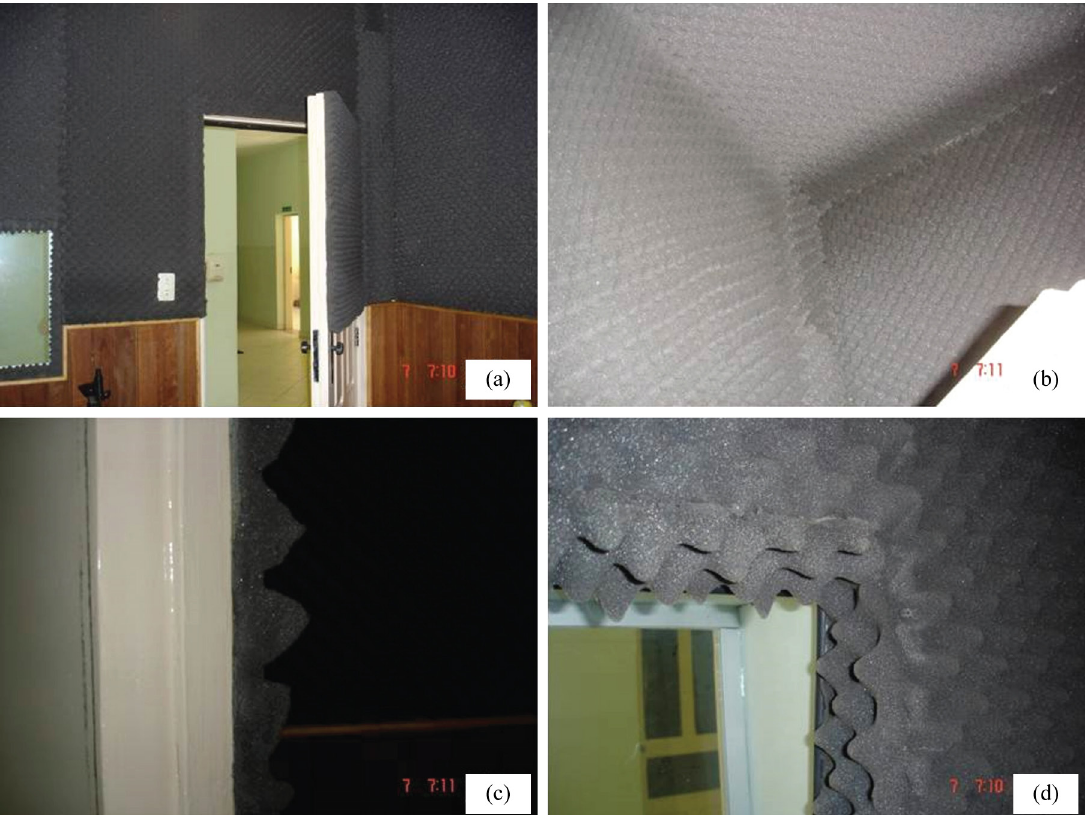
Figure 2. Location of the assembly of the experiment; (a) Rehearsal studio; (b) Coating on superior part of the room; (c) Detail of the thickness of the door; (d) Detail of the window double glazing.